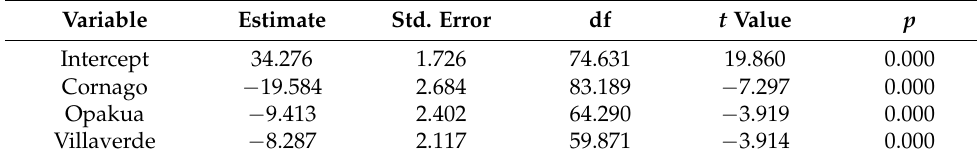
Table 3. Summary of the linear mixed-effect models proposed to study growth trajectories and response to climate of Douglas fir. Variables’ abbreviations: df, degrees of freedom; SPEI, 3-month August SPEI; Tmax, August maximum temperature. Ages are log-transformed